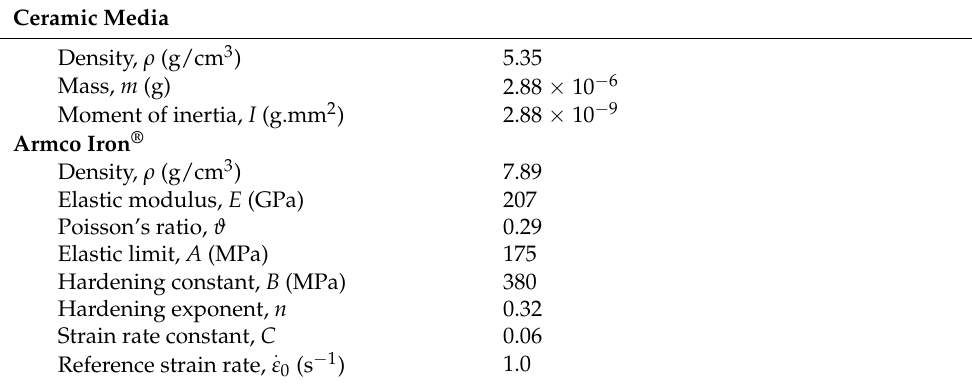
Table 1. Material parameters used in the modeling (data taken from [48] ).